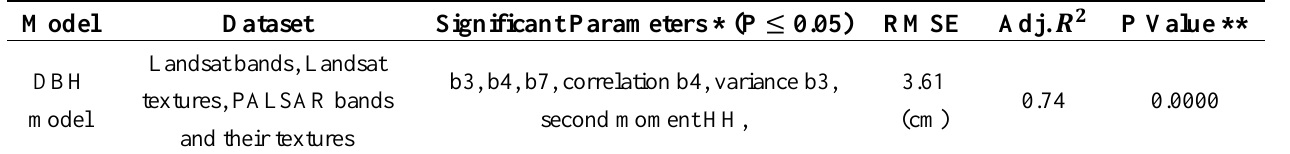
Table 7. Statistics summary of DBH estimation model.